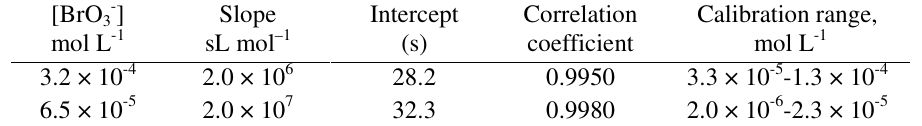
Table 1. Linear regression parameters of calibration data for different concentrations of